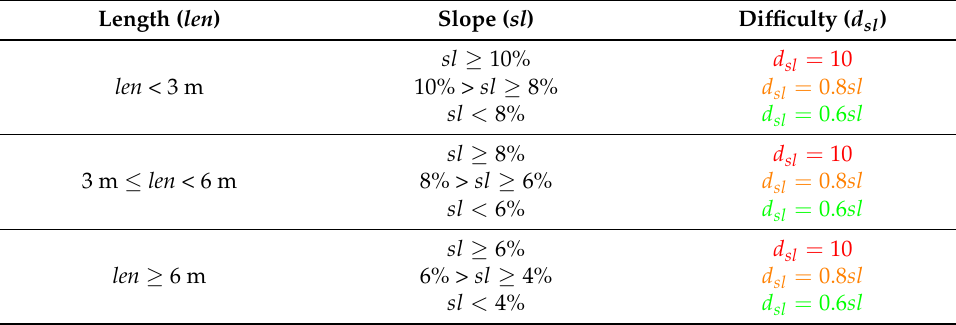
Table 1. The difficulty of a street attending to its recommended slope and length.